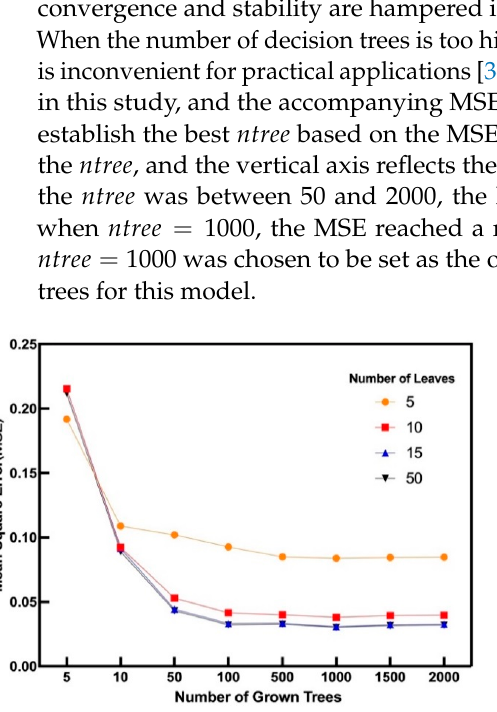
Figure 10. The MSE results of the random forest model under different numbers of decision trees and leaf nodes.